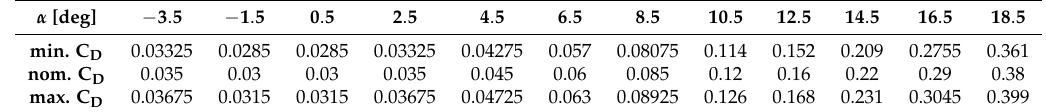
Table 4. Uncertain Parameters: drag coefficient, C D ( α ) .